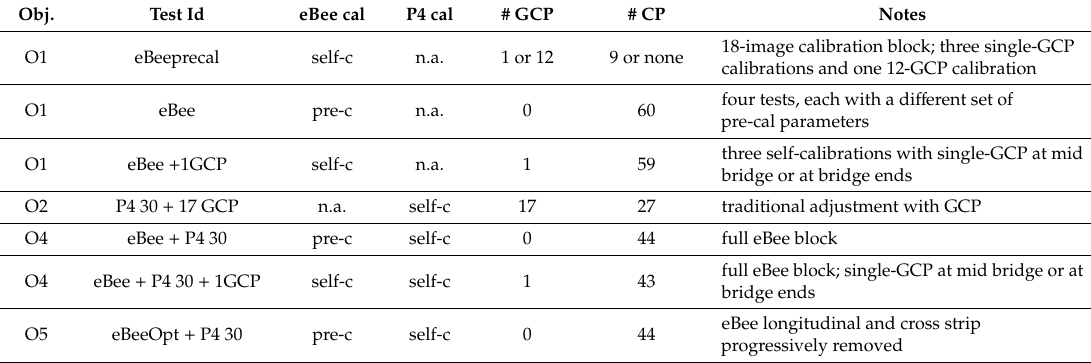
Table 2. Summary of the tests performed. See above for the meaning of the test Id. Obj.